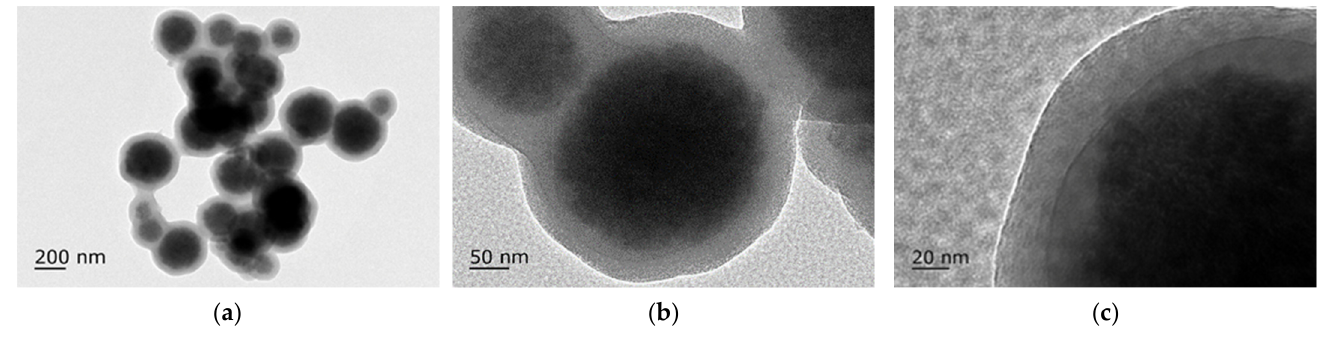
Figure 2. ( a ) TEM image of core-shell Fe 3 O 4 -SiO 2 magnetic nanoparticles with good dispersity; ( b , c ) high-resolution TEM images of core-shell Fe 3 O 4 -SiO 2 magnetic nanoparticles with obvious Fe 3 O 4 core and silica layer. (unpublished data, Jingyi Xue, 2022).